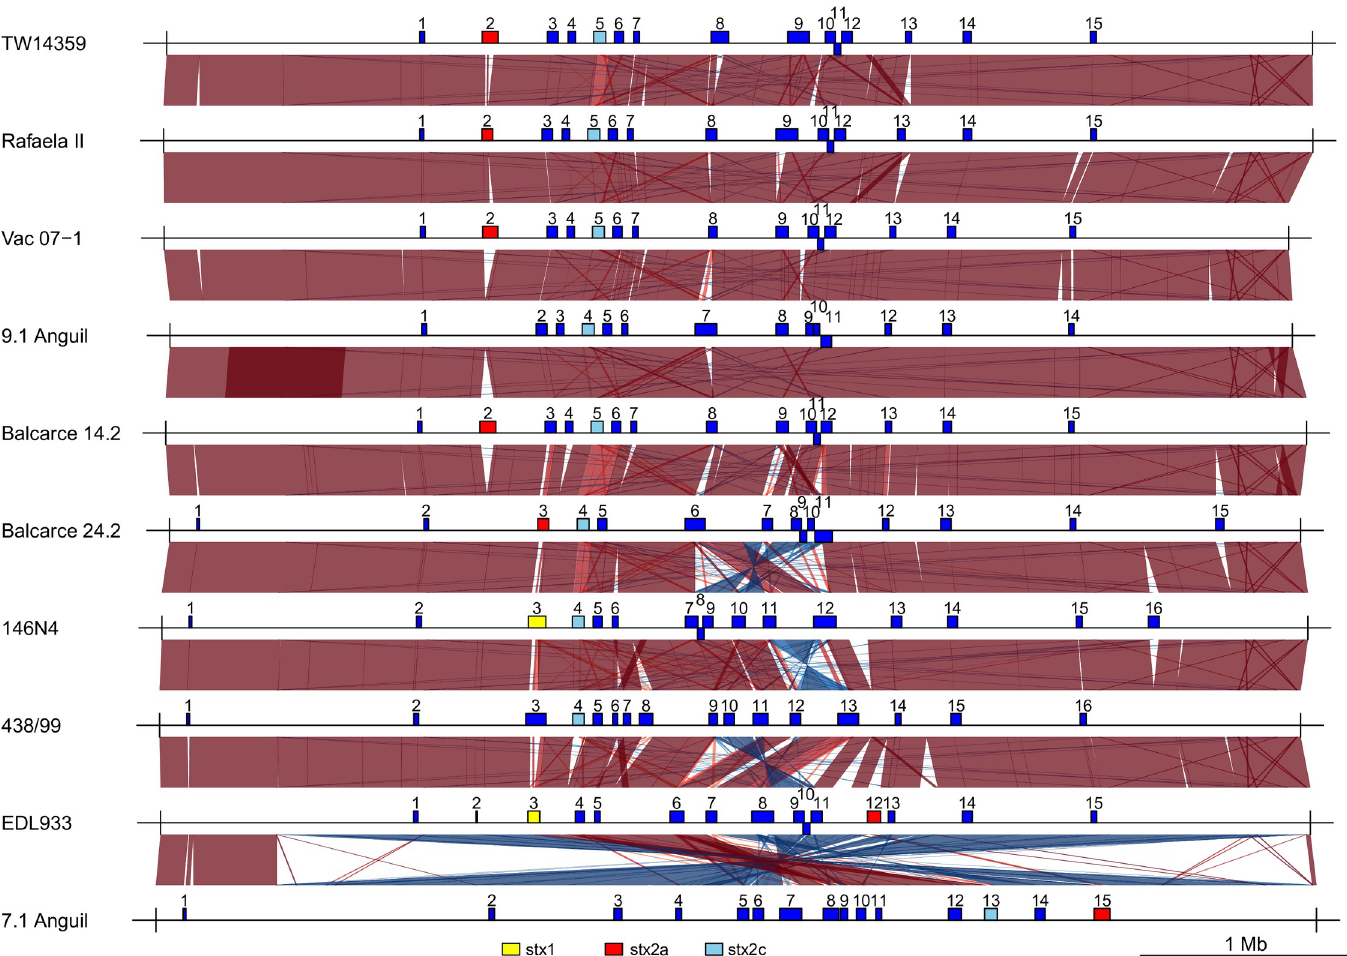
Fig 1. Schematic lineal representation of aligned EHEC O157 genomes. The origin of replication is placed at the 5´and 3’end. Lambdoid prophages are represented as boxes of blue color, except for those carrying stx genes. In those cases, stx1 , stx2 a and stx2 c prophages were indicated in yellow, red and light blue boxes, respectively. Artemis comparison tool was used to indicate regions of similarity (red), inversions (blue) and In/dels (clear).